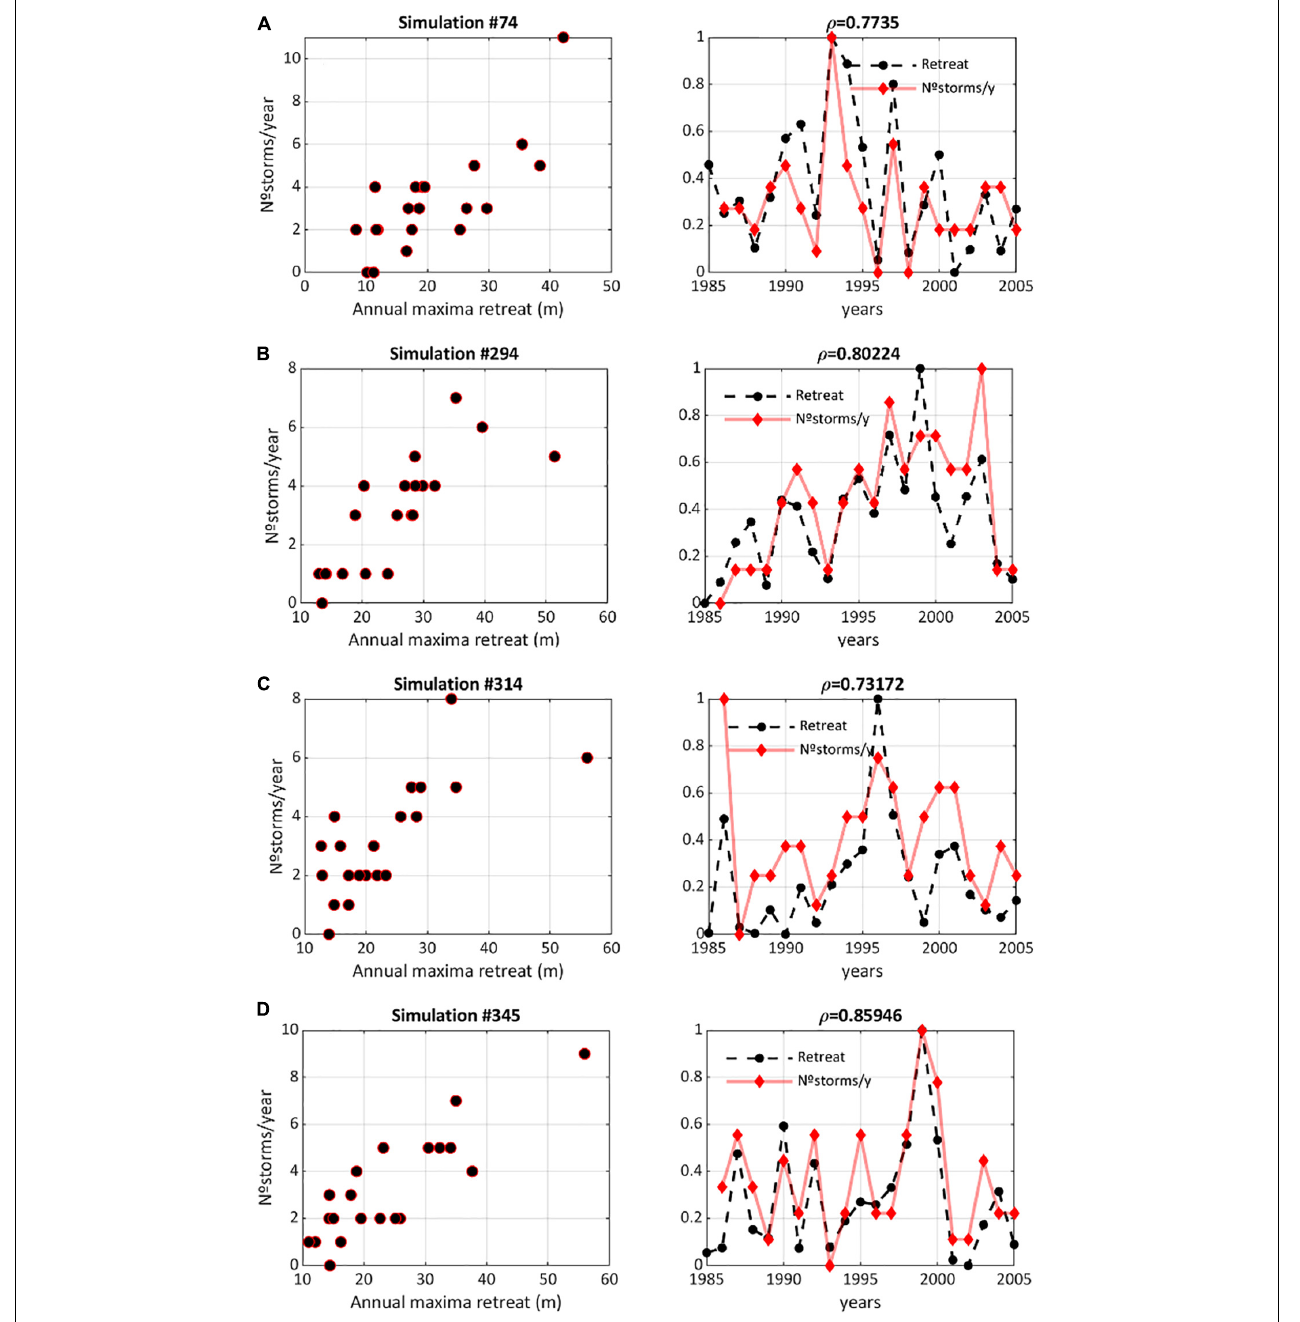
FIGURE 11 | Scatter plot of the annual maxima shoreline retreat compared to the annual number of storms (left column). Time series of the normalised annual maxima shoreline retreat and normalised annual number of storms for the simulations #74 (A) , #294 (B) , #314 (C) , and #345 (D) of SP2 associated with the IPSL-CM5A-MR model in the historical period (1985–2005) (right